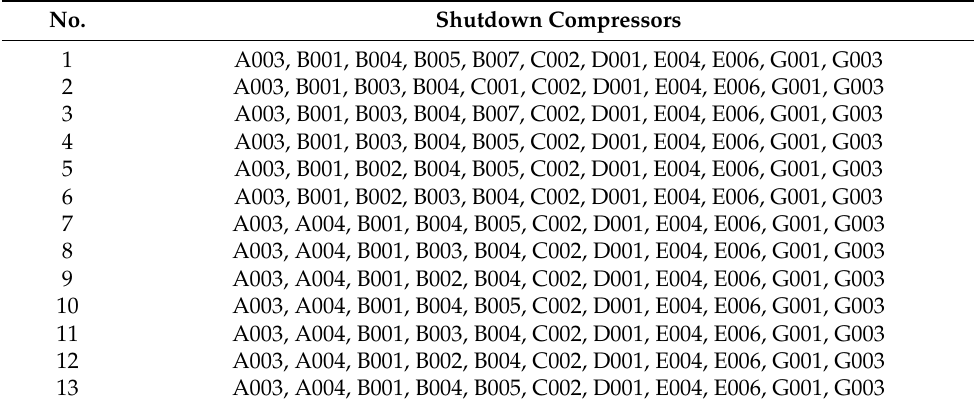
Table 6. Positions of the faulted compressors.